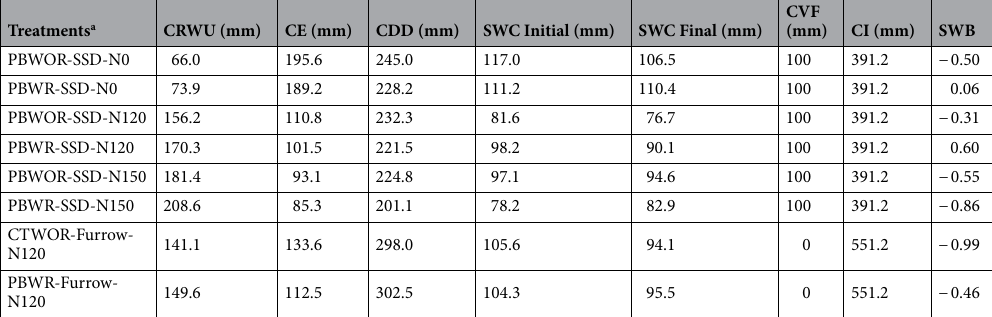
Treatments a Plots with furrow irrigation Plots with subsurface drip